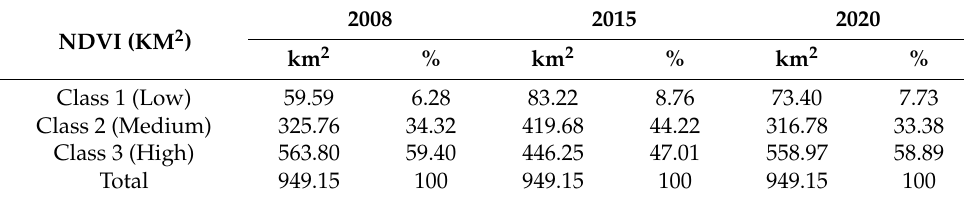
Table 2. Change of the NDVI density classes between 2008, 2015, and